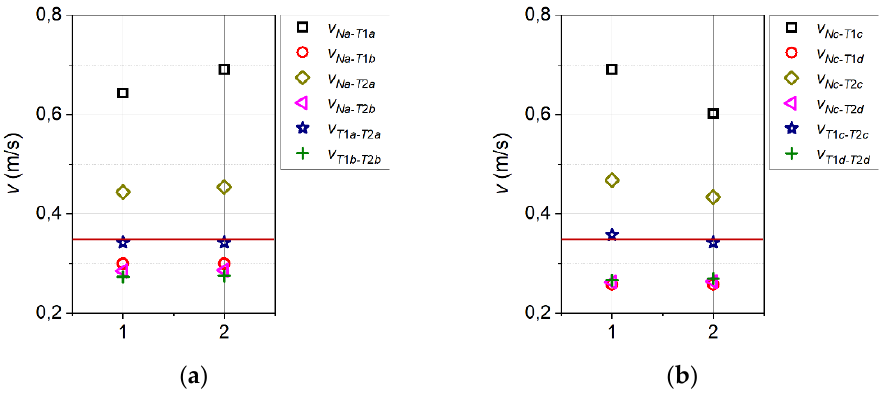
Figure 11. Velocity maps made with the use of selected characteristic points related to the voltage signals rising ( a ) and falling ( b ) edges. For clarity, velocities resulting from pairs of points not corresponding to each other were omitted. The same applies to pairs containing point Nb. The numbers along the horizontal axes indicate whether the data columns correspond to the first or second thermal wave period.